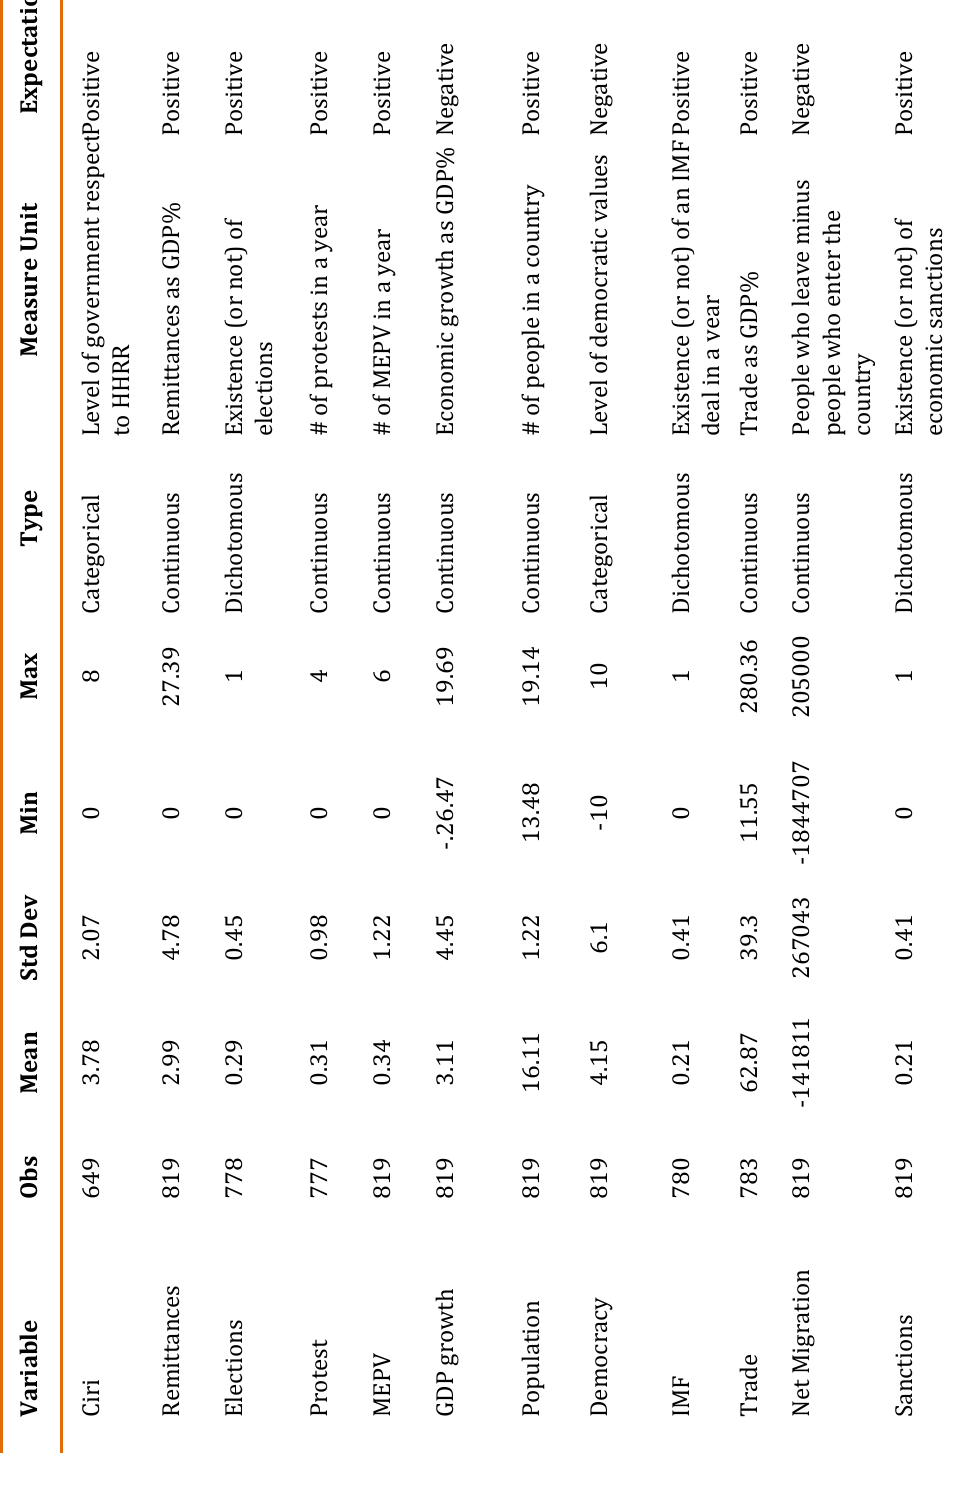
Table 01. Summary statistics of variables used to calculate the effect of remittances on the level of violations of rights to physical integrity